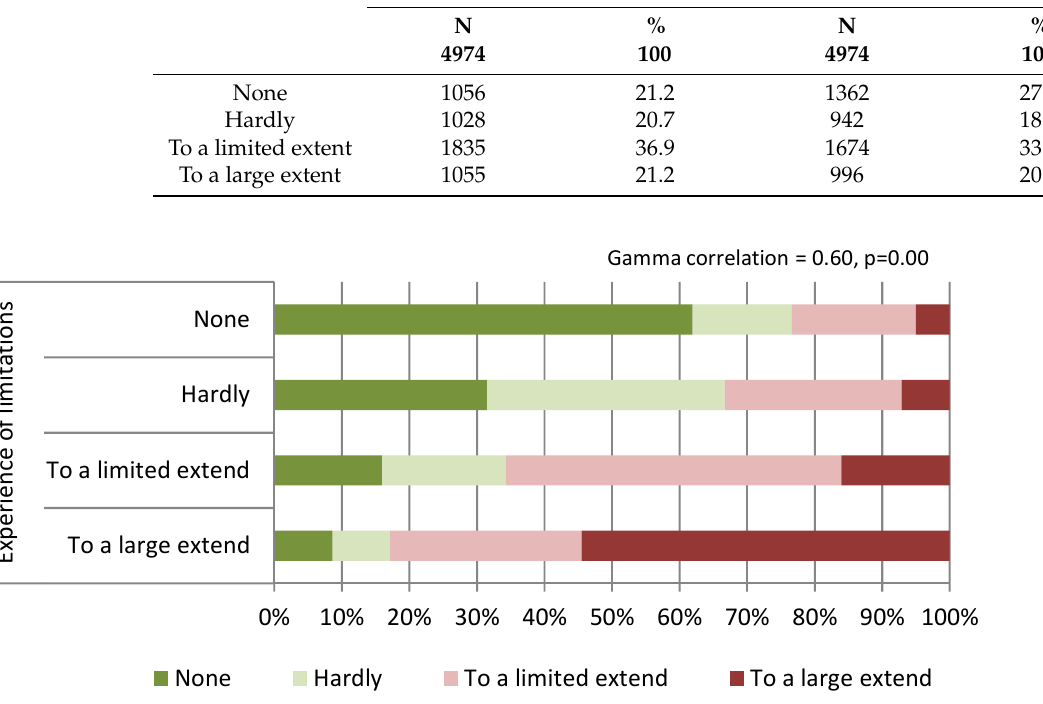
Figure 3. Correlation of experiencing limitations and considering making adjustments. Table 3. Experienced limitations to the practice infrastructure and considered making adjustments to the infrastructure as an effect of the COVID-19 pandemic.